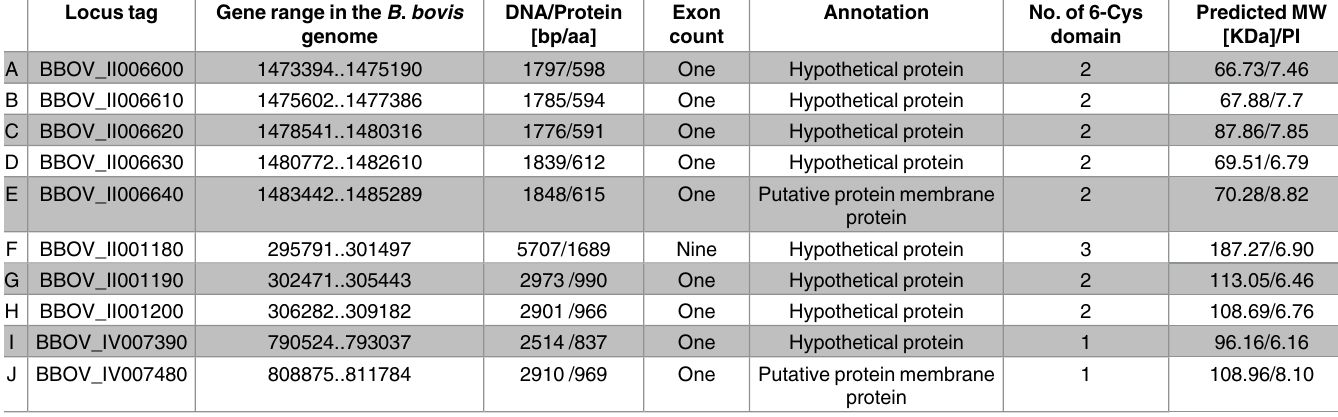
Table 1. Predicted features of the B . bovis 6-Cys family genes and their putative proteins. Locus tag Gene range in the B . bovis DNA/Protein Exon genome [bp/aa]